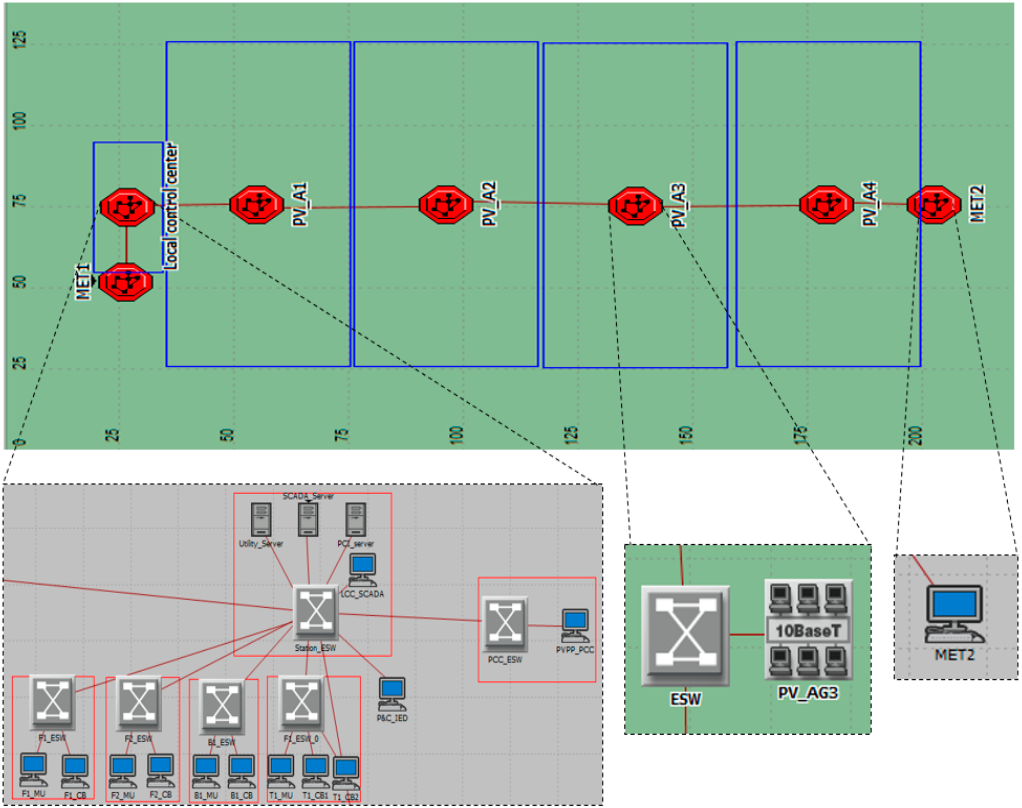
11 of 17 Figure 5. Proposed communication network model for the PV power plant. PVG: PV generator; PCU: power conditioning unit F: feeder; B: bus; T: transformer, LV: low voltage; MV: medium voltage. In a real PV power plant, independent communication networks are used to support different applications (sometimes from different service providers) where all subnetworks are connected together via a common backbone network. In this work, independent communication networks (independent communication links and switches) are considered to support different applications (PV arrays, protection and control and utility grid). Figure 6 shows the OPNET simulation model for the PV power plant. It consists of seven octagons representing four PV arrays, two meteorological masts and one control center. The configuration is based on the actual PV power plant dimensions. Two scenarios are considered: fixed mounted PV arrays (no tracker tilt angle nor tracker azimuth angle) and PV arrays with sun trackers (each PV sun tracking unit is equipped with a pyranometer). Two different link capacities are considered for local area communication (LAN): 10 BaseT and 100 BaseT. The traffic configuration,